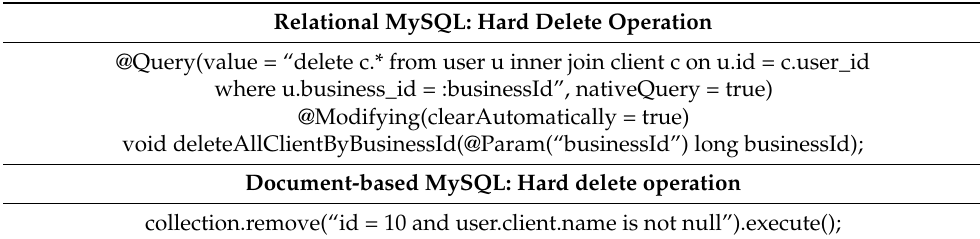
Table 13. Hard delete operation.